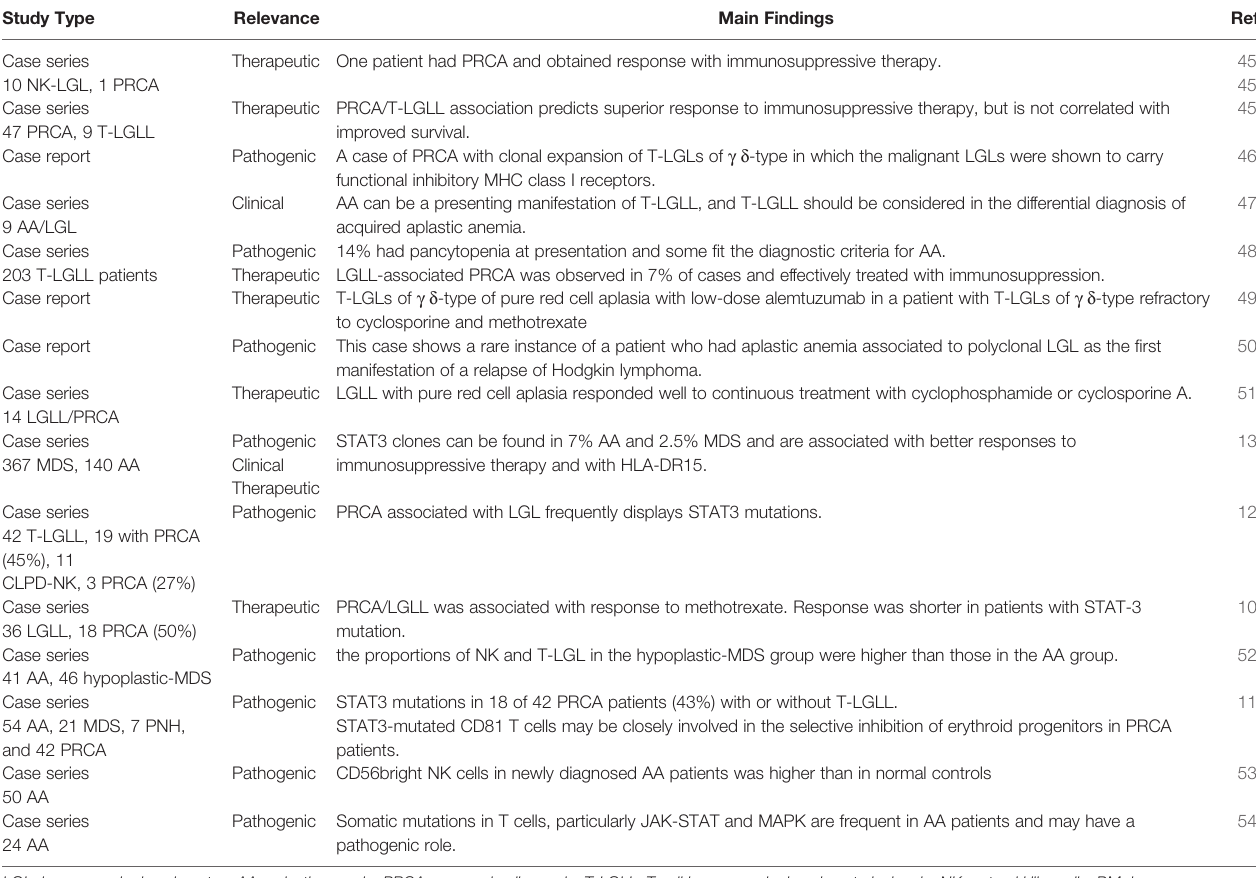
TABLE 3 | Large granular lymphocytes in aplastic anemia and pure red cell